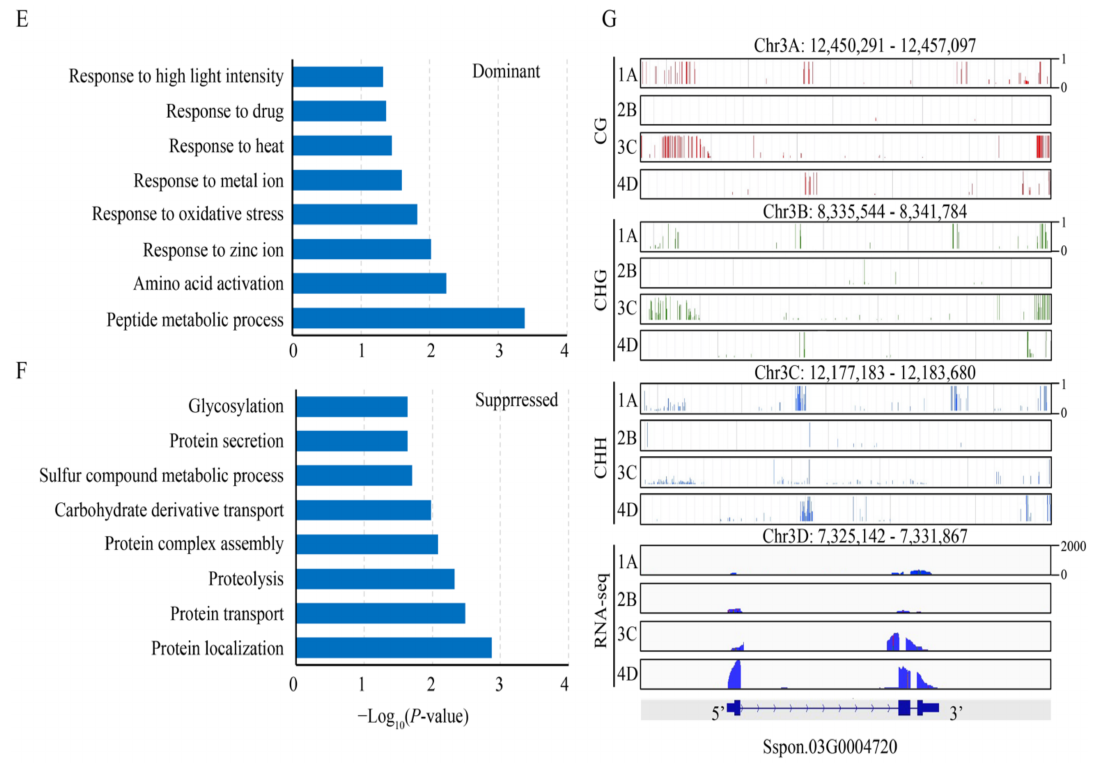
Figure 5. Allele-specific expression and DNA methylation. ( A ) DNA methylation divergence between dominant and non-dominant tetrad alleles in CG, CHG, and CHH sequence contexts. ( B ) DNA methylation divergence between suppressed and non-suppressed tetrad alleles in CG, CHG, and CHH sequence contexts. ( C , D ) Venn diagram showing the overlap of alleles regulated by DNA methylation in all three contexts from dominant categories ( C ) and suppressed categories ( D ). ( E ) Enriched GO terms of DNA methylation-associated dominant category alleles. ( F ) Enriched GO terms of DNA methylation-associated suppressed category alleles. ( G ) Snapshot of example dominant tetrad alleles with varied DNA